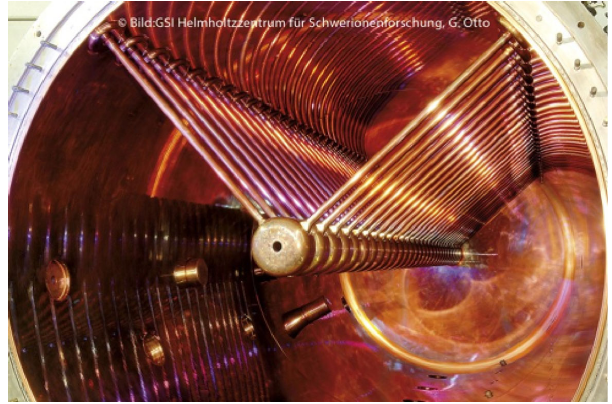
FIG. 3. Today ’ s first tank of the Alvarez-type DTL of the Universal Linear Accelerator UNILAC at GSI [18]. The stems are installed in the constant V-configuration.